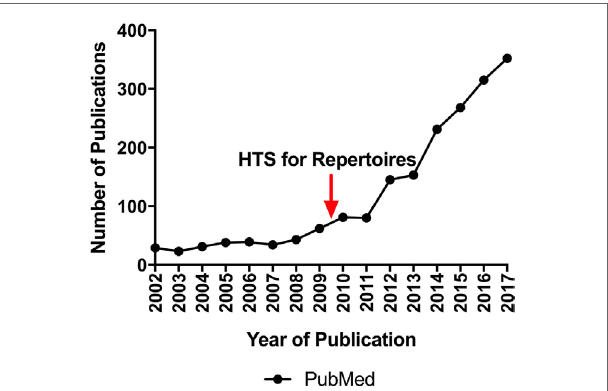
FIguRe 1 | The number of newly published repertoire sequencing papers appearing in PubMed each year over the last 15 years. For 2002, the number was obtained by the query ((repertoire sequencing) AND (2002 [dp])). The number for 2017 is a projection based on the number appearing between January and December 2017. The red arrow indicates the year in which publications demonstrated the feasibility of applying high-throughput sequencing to immune